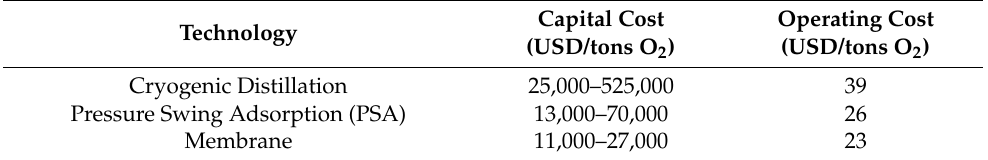
Table 1. Capital and operating costs for producing 30 mol% oxygen by different technologies